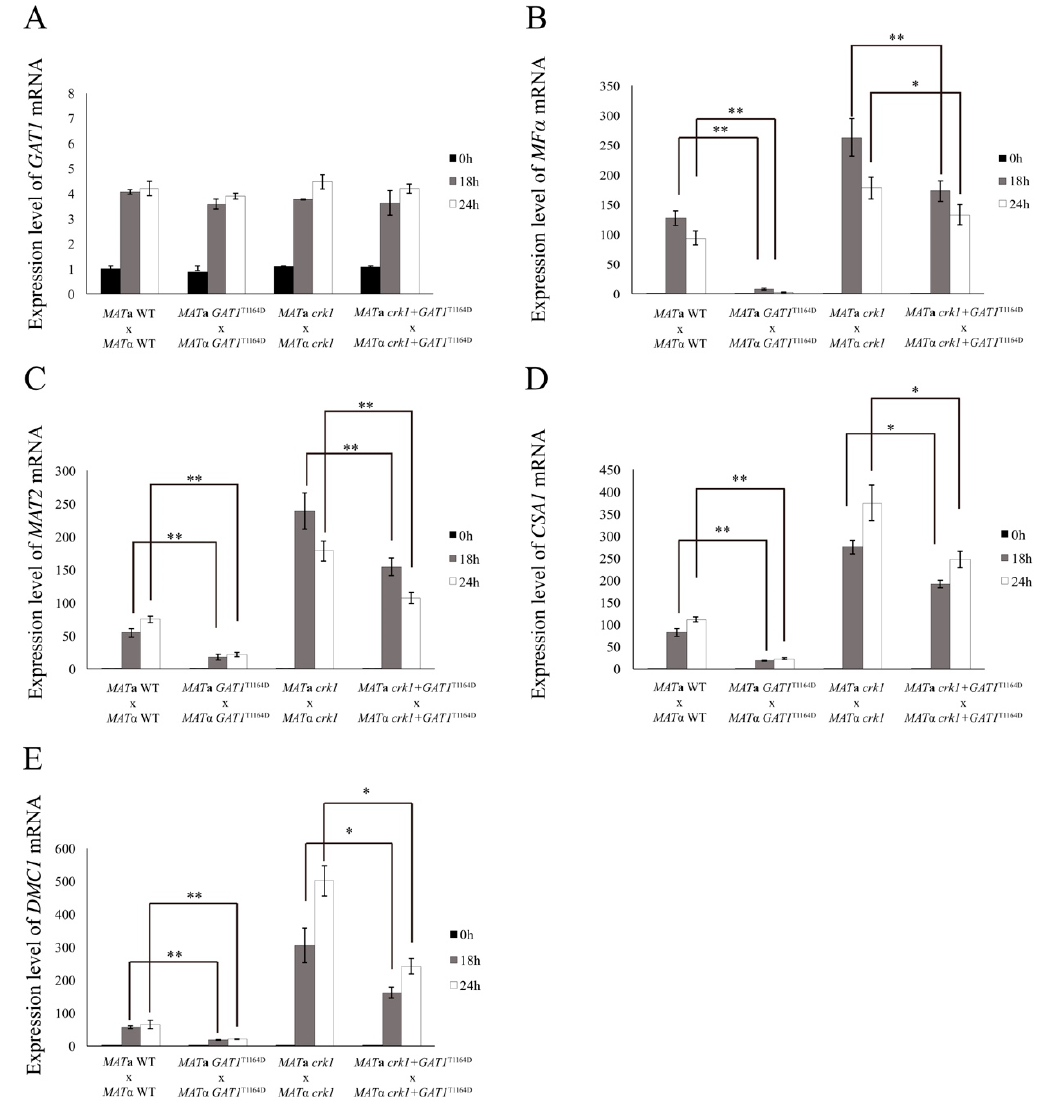
Figure 10. The expression of mating-related genes was down-regulated by the GAT1 phospho-mimetic allele. C. neoformans MAT a and MAT α strains were crossed as indicated. Mating was conducted on V8 agar plates and incubated at 26 ◦ C in the dark. Samples were collected at 0, 18, and 24 h post-incubation. The expression of GAT1 ( A ), MF α ( B ), MAT2 ( C ), CSA1 ( D ), and DMC1 ( E ) was examined by real-time qRT-PCR analysis. Triplicate reactions for each sample were conducted. Error bar represents the standard deviation from the mean of three replicates. The results were normalized to C. neoformans GPD1 expression. (** indicates p < 0.005; * indicates p < 0.05).